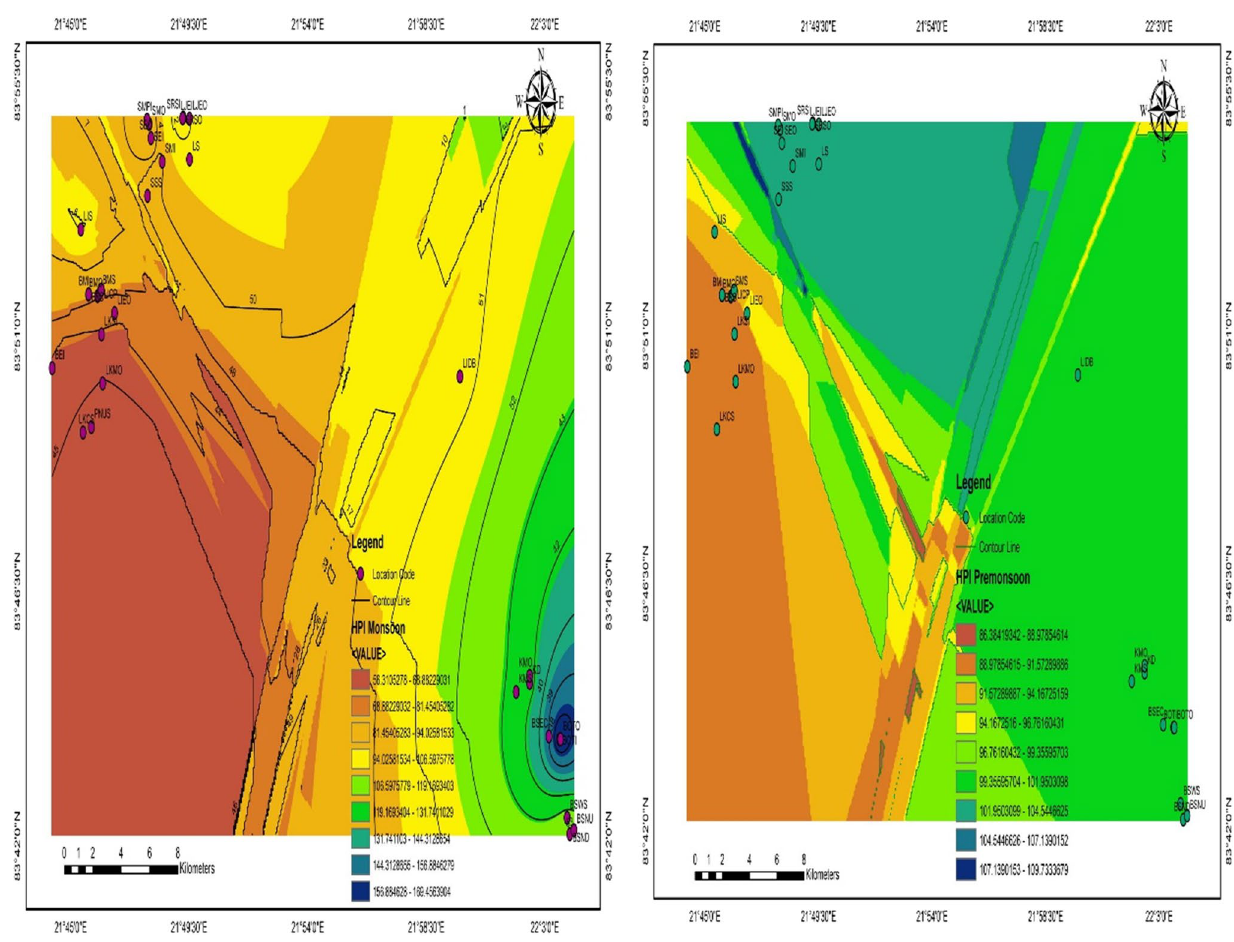
Fig. 14 Contour map of HPI concentration in water samples during premonsoon and monsoon